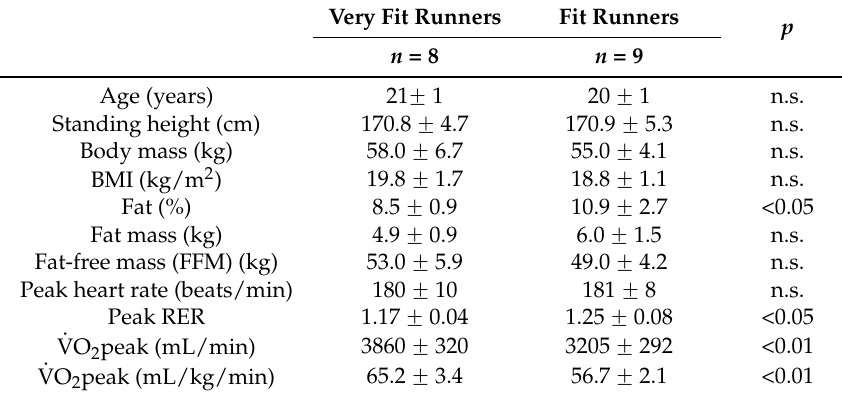
Table 1. Subject